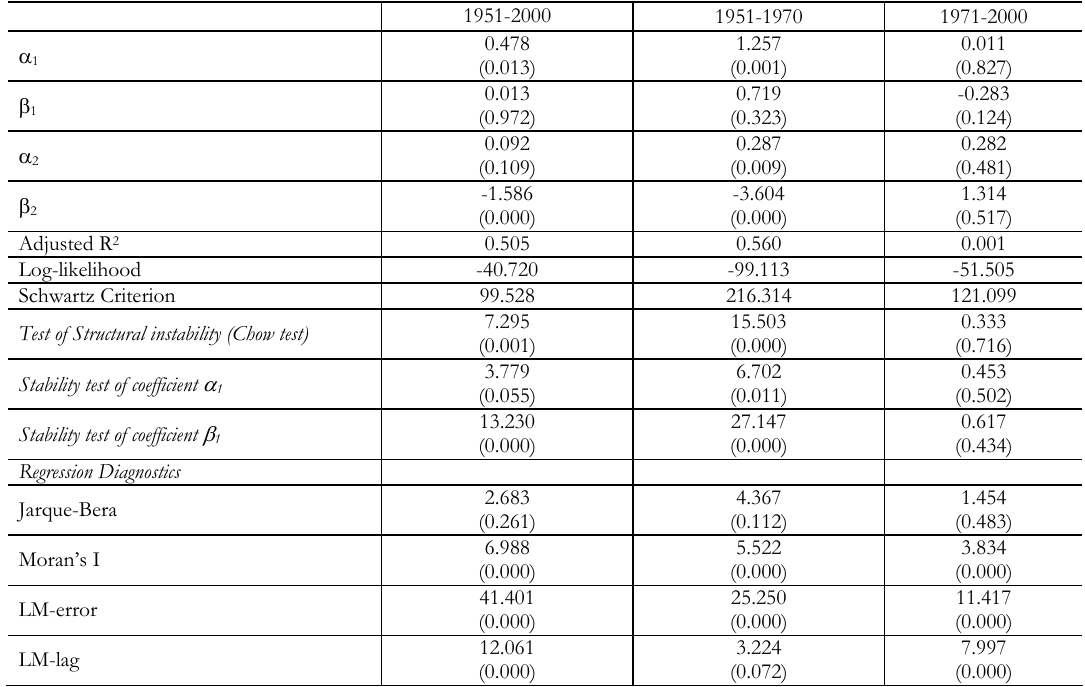
Per Capita Income Growth of Italian Provinces Multiple Regime Models – OLS Estimates (Number into brackets refer to the